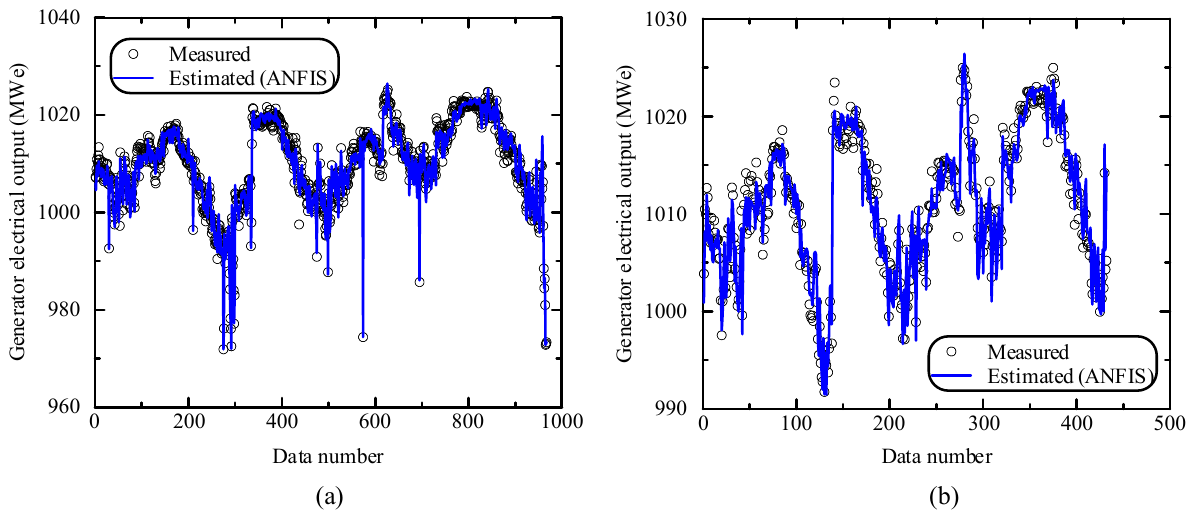
Figure 10. ( a ) Training results for the ANFIS based turbine cycle model; ( b ) Comparison between the measured values and the validated results of the ANFIS